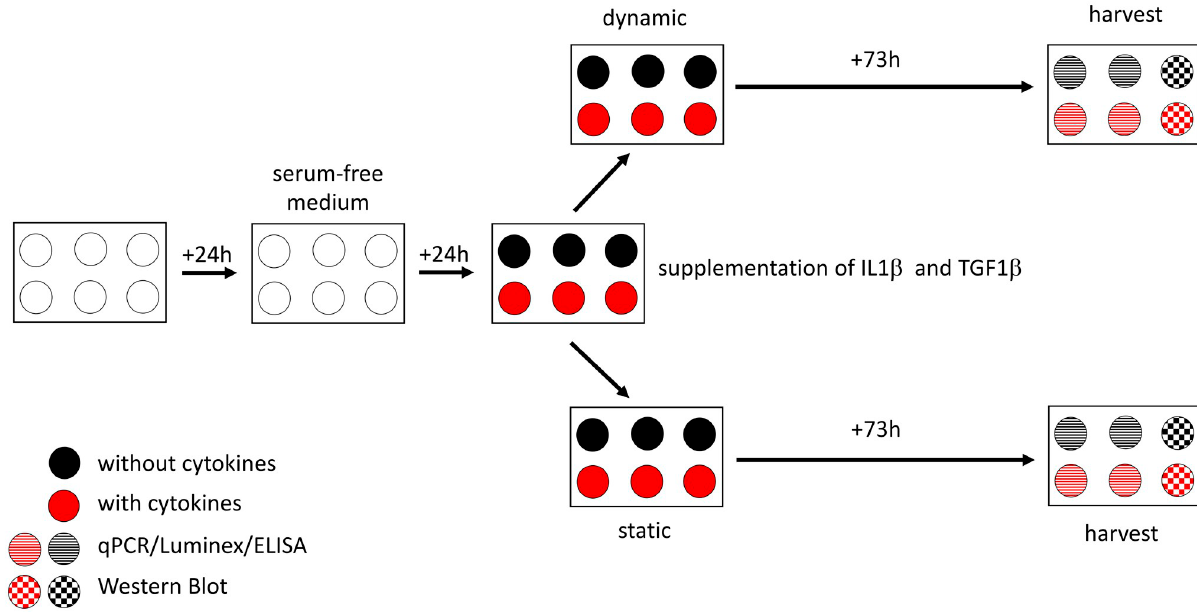
Fig 1. Experimental design. Twenty-four hours after seeding the cells, the cell culture medium was changed to a serum-free medium for starvation. The next day, cells were divided into four groups with different conditions (with or without cytokines–static or dynamic). After a further 73 hours, cells were harvested. Two wells of each condition were used for qPCR, Luminex as well as ELISA and one for Western Blot. All samples were taken into account for LDH assay.